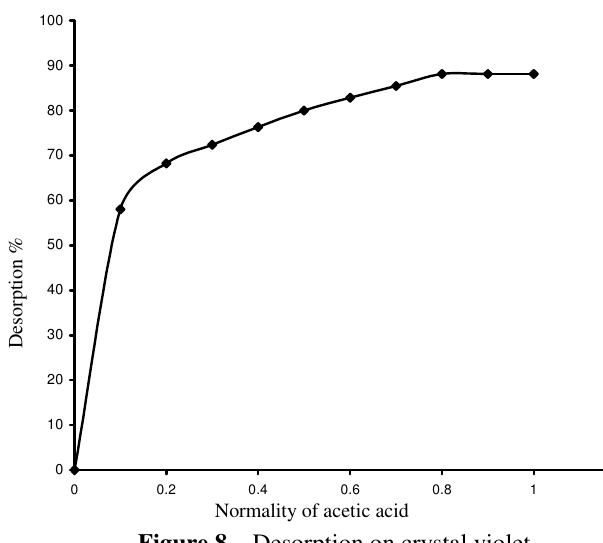
Figure 8. Desorption on crystal